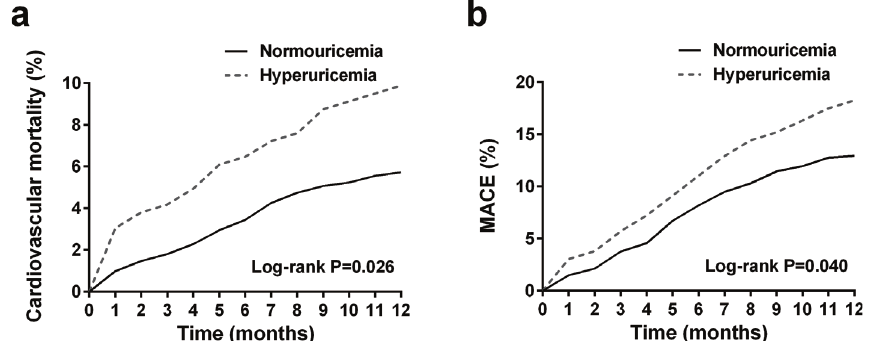
Fig. 3. Kaplan–Meier curves of 1-year cardiovascular mortality (a) and major adverse cardiovascular events (MACEs) accord- ing to the presence of